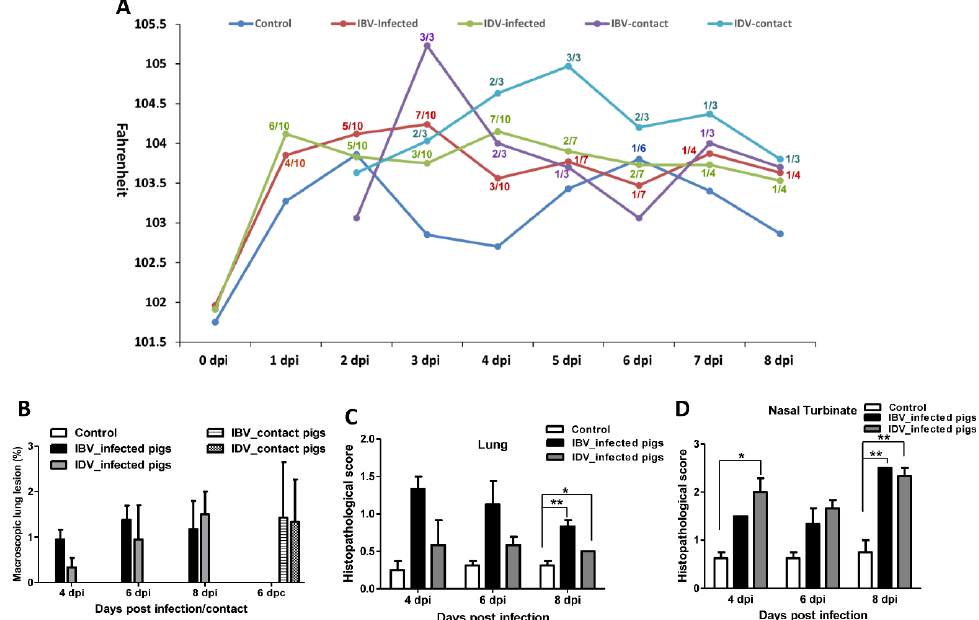
Figure 1. Body temperature, macroscopic, and microscopic lungs lesions of contact or infected pigs with influenza B virus (IBV), or influenza D virus (IDV). ( A ) The body temperature of infected or contact pigs is presented as the average body temperature of each group of pigs at indicated days. The number, such as 6/10, means that 6 out of 10 IDV-infected pigs showed fever at a defined dpi. ( B ) Macroscopic lung lesions of infected or contact pigs are presented as the average percentage ± SEM of gross lesions of three or four pigs in each group at the indicated days. ( C , D ) Microscopic lung ( C ) and nasal turbinate ( D ) lesions of infected pigs are presented as the Mean ± SEM of lesions of three or four pigs in each group at the indicated days. The asterisks (*) represent a statistically significant difference between groups (*: p < 0.05; **: p < 0.01).